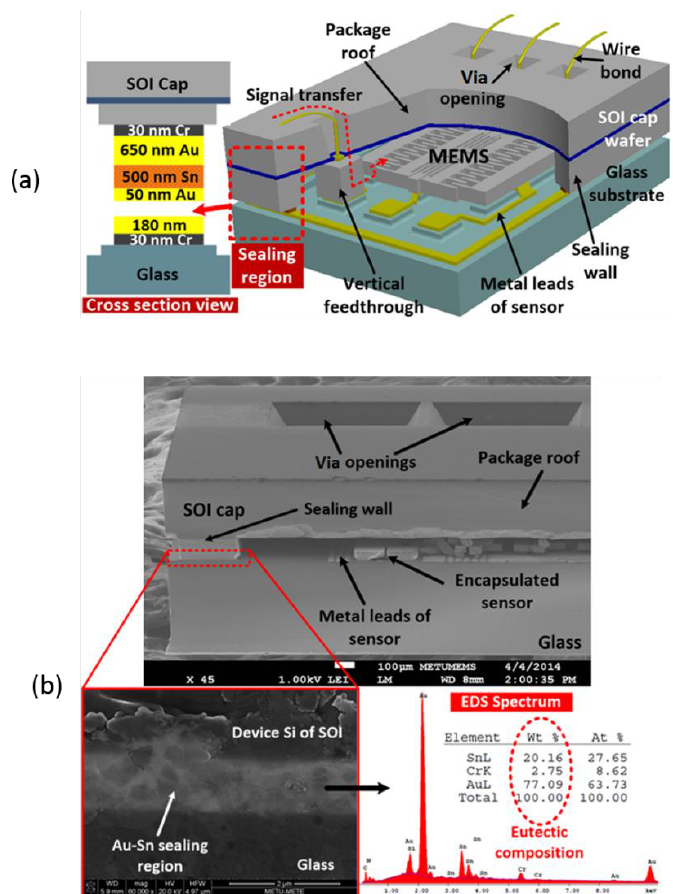
Figure 4. Alternating layers of evaporated Au and Sn are used to form the Au 0.8 Sn 0.2 eutectic bond for the wafer-level packaging (WLVP) of a microelectromechanical (MEMS) resonator [35]. ( a ) Cartoon depicting the embodiment; ( b ) Scanning electron microscope (SEM) image of the completed structure including the Au 0.8 Sn 0.2 eutectic bond. Reprinted from ref. [35] with permission from the Institute of Electrical and Electronics Engineers (IEEE).